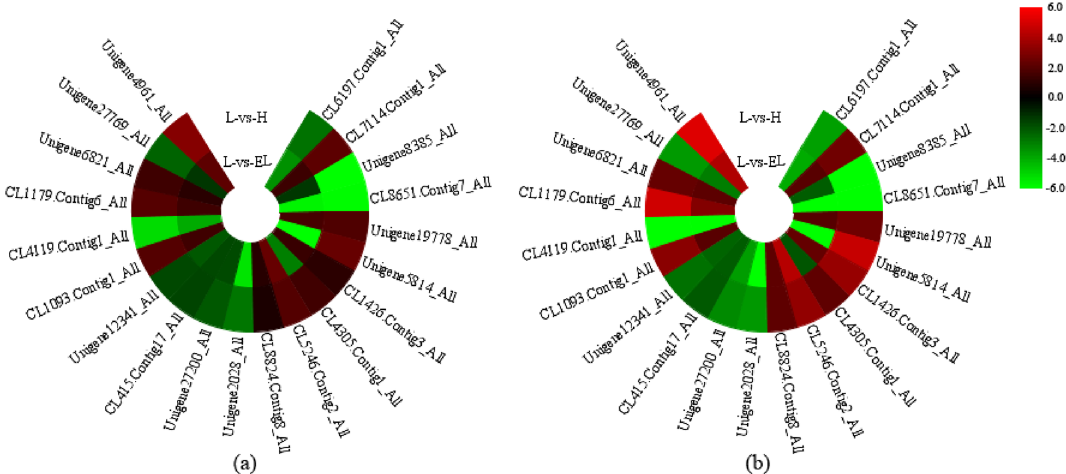
Figure 5. Expression levels of 20 differentially expressed genes obtained by qRT-PCR; ( a ) were used to validate the RNA-seq data ( b ). Both the qRT-PCR and the RNA-seq data are the mean values of three biological replicates. The colour gradient from green to red indicates low to high gene expression. H, EL, and L represent nitrogen excess, nitrogen starvation, and control treatment,